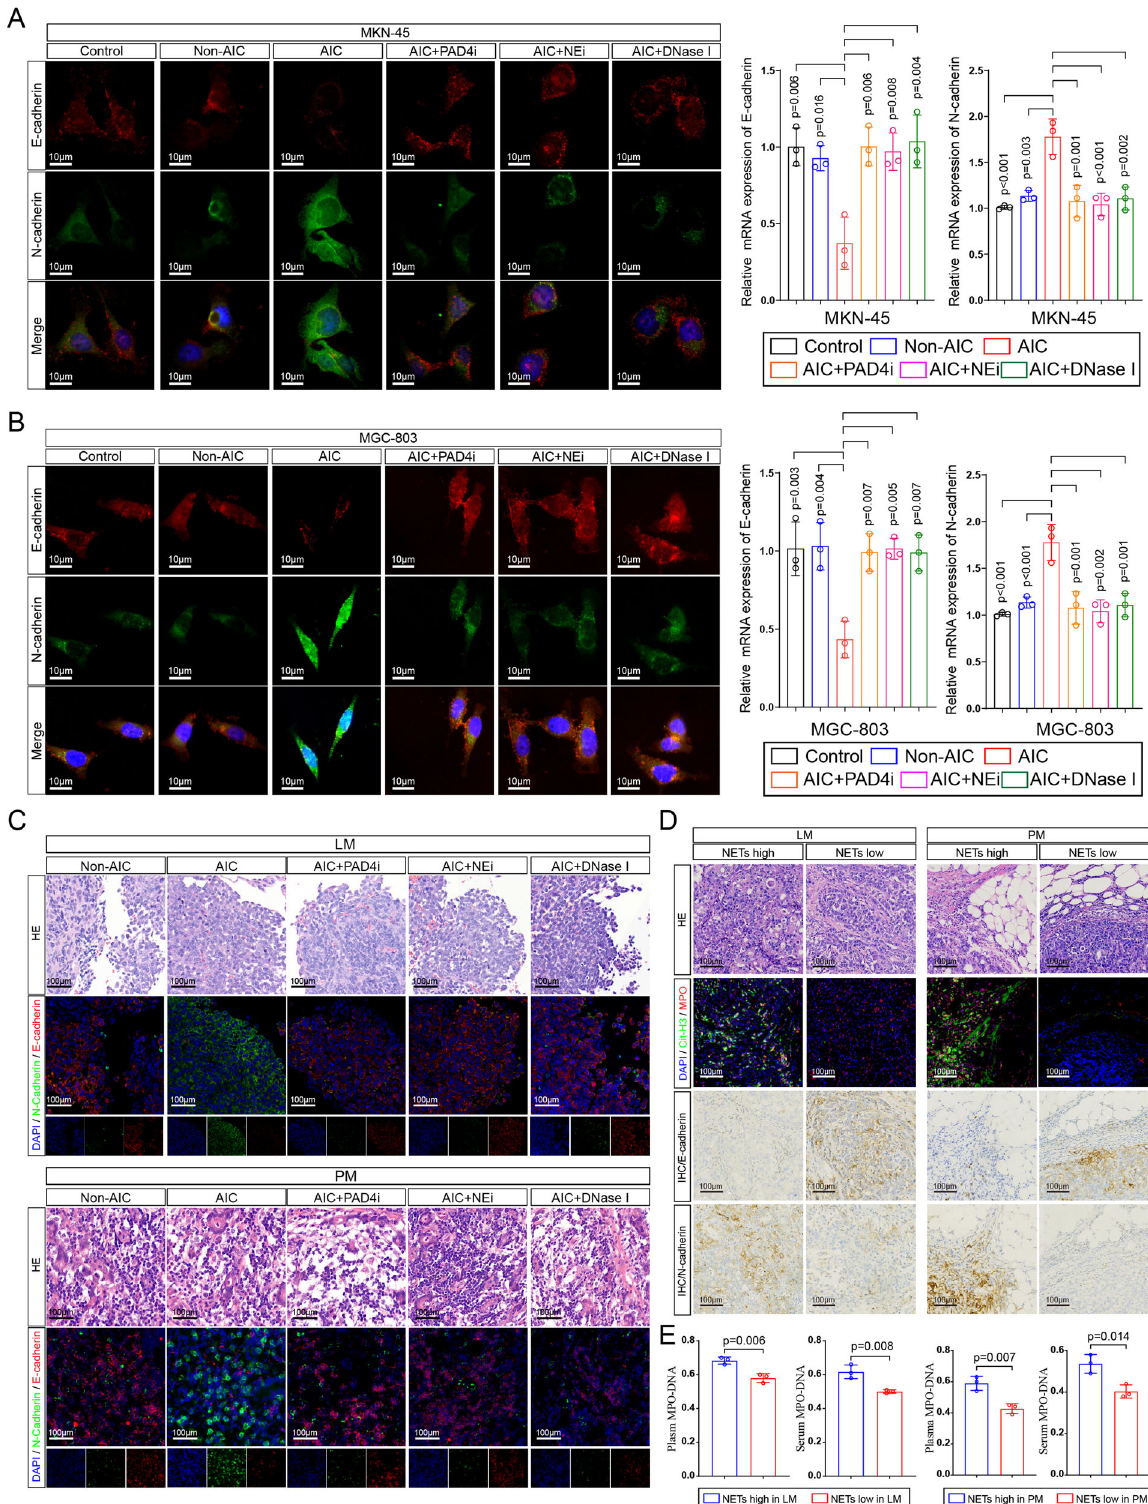
Fig. 3 NETs modulate EMT in GC cells. A , B Left panel: representative immuno fl uorescence co-staining of DNA, E-cadherin and N-cadherin in MKN-45 ( A ) and MGC-803 ( B ) cells as indicated treatments (PADi, NEi, or DNase I were used to inhibit NETs speci fi cally). Right panel: The mRNA levels of E-cadherin and N-cadherin in MKN-45 and MGC-803 cells as indicated treatments were assayed by quantitative reverse transcriptase (qRT) – PCR; C Representative HE (metastatic lesions) and immuno fl uorescence co-staining images of DNA, E-cadherin and N-cadherin in liver (upper panel), and peritoneum (down panel) collected from LM and PM nude mice ( n = 5 per group) as indicated in Fig. 2C, D; D Representative HE, immuno fl uorescence co-staining images of DNA, Cit-H3, and MPO, immunohistochemical images for E-cadherin and N-cadherin in metastatic leasions from GC patients with LM ( n = 3) or PM ( n = 3); E Plasma and serum levels of MPO – DNA in GC patients as indicated in Fig. 3D. Data represent the mean±S.D. in A , B ( n = 3 biologically independent experiments) and D , E ( n = 3 per group); one-way ANOVA with Tukey test was used in A , B ; Unpaired Student ’ s t -tests were used in E . Source data are provided as a Source Data fi